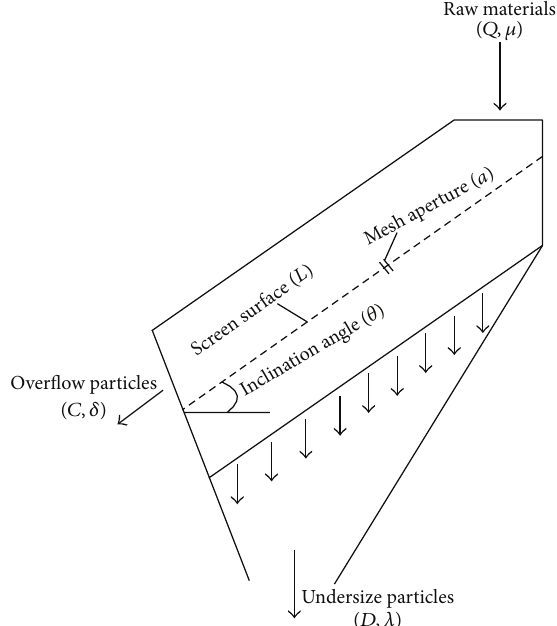
Figure 2: Schematic diagram of total efficiency